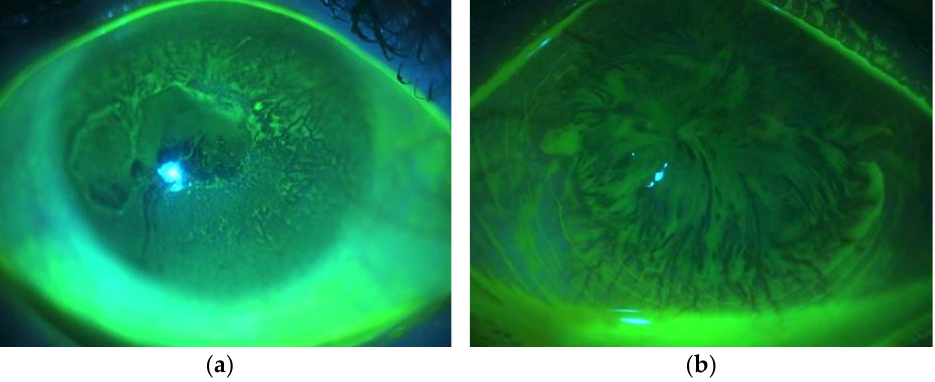
Figure 1. Slit-lamp biomicroscopy images pattern of abnormal fluorescent staining. ( a ) the central area of normal corneal epithelium is surrounded by the epithelium with abnormal staining (partial LSCD), and ( b ) “whorl-like epitheliopathy” (total